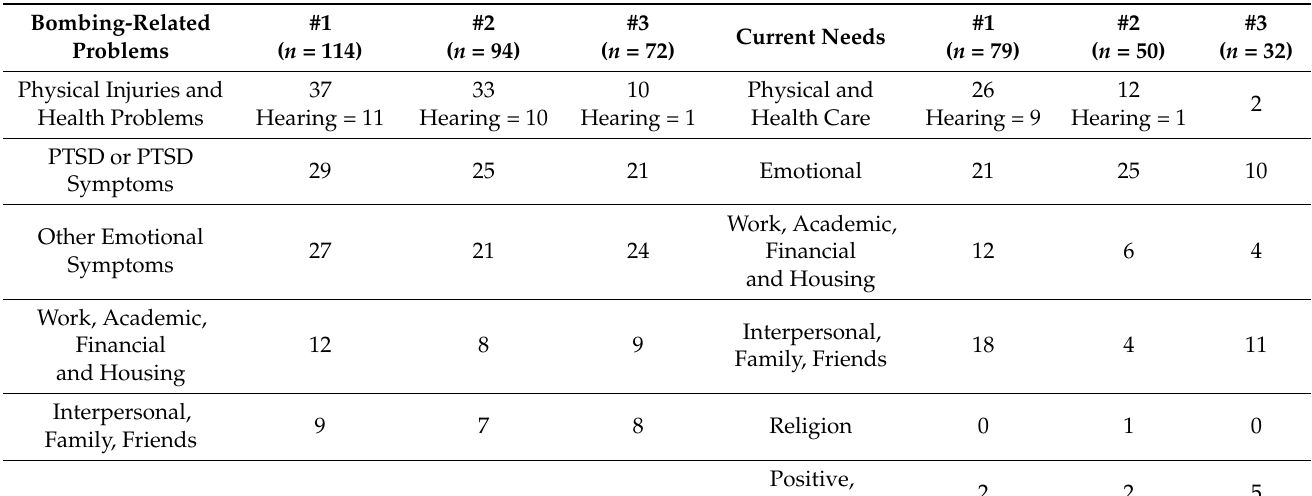
Table 3. Most Important Bombing-Related Problems and Current Needs. 114 survivors had at least 1 response to questions. Responses are grouped according to general